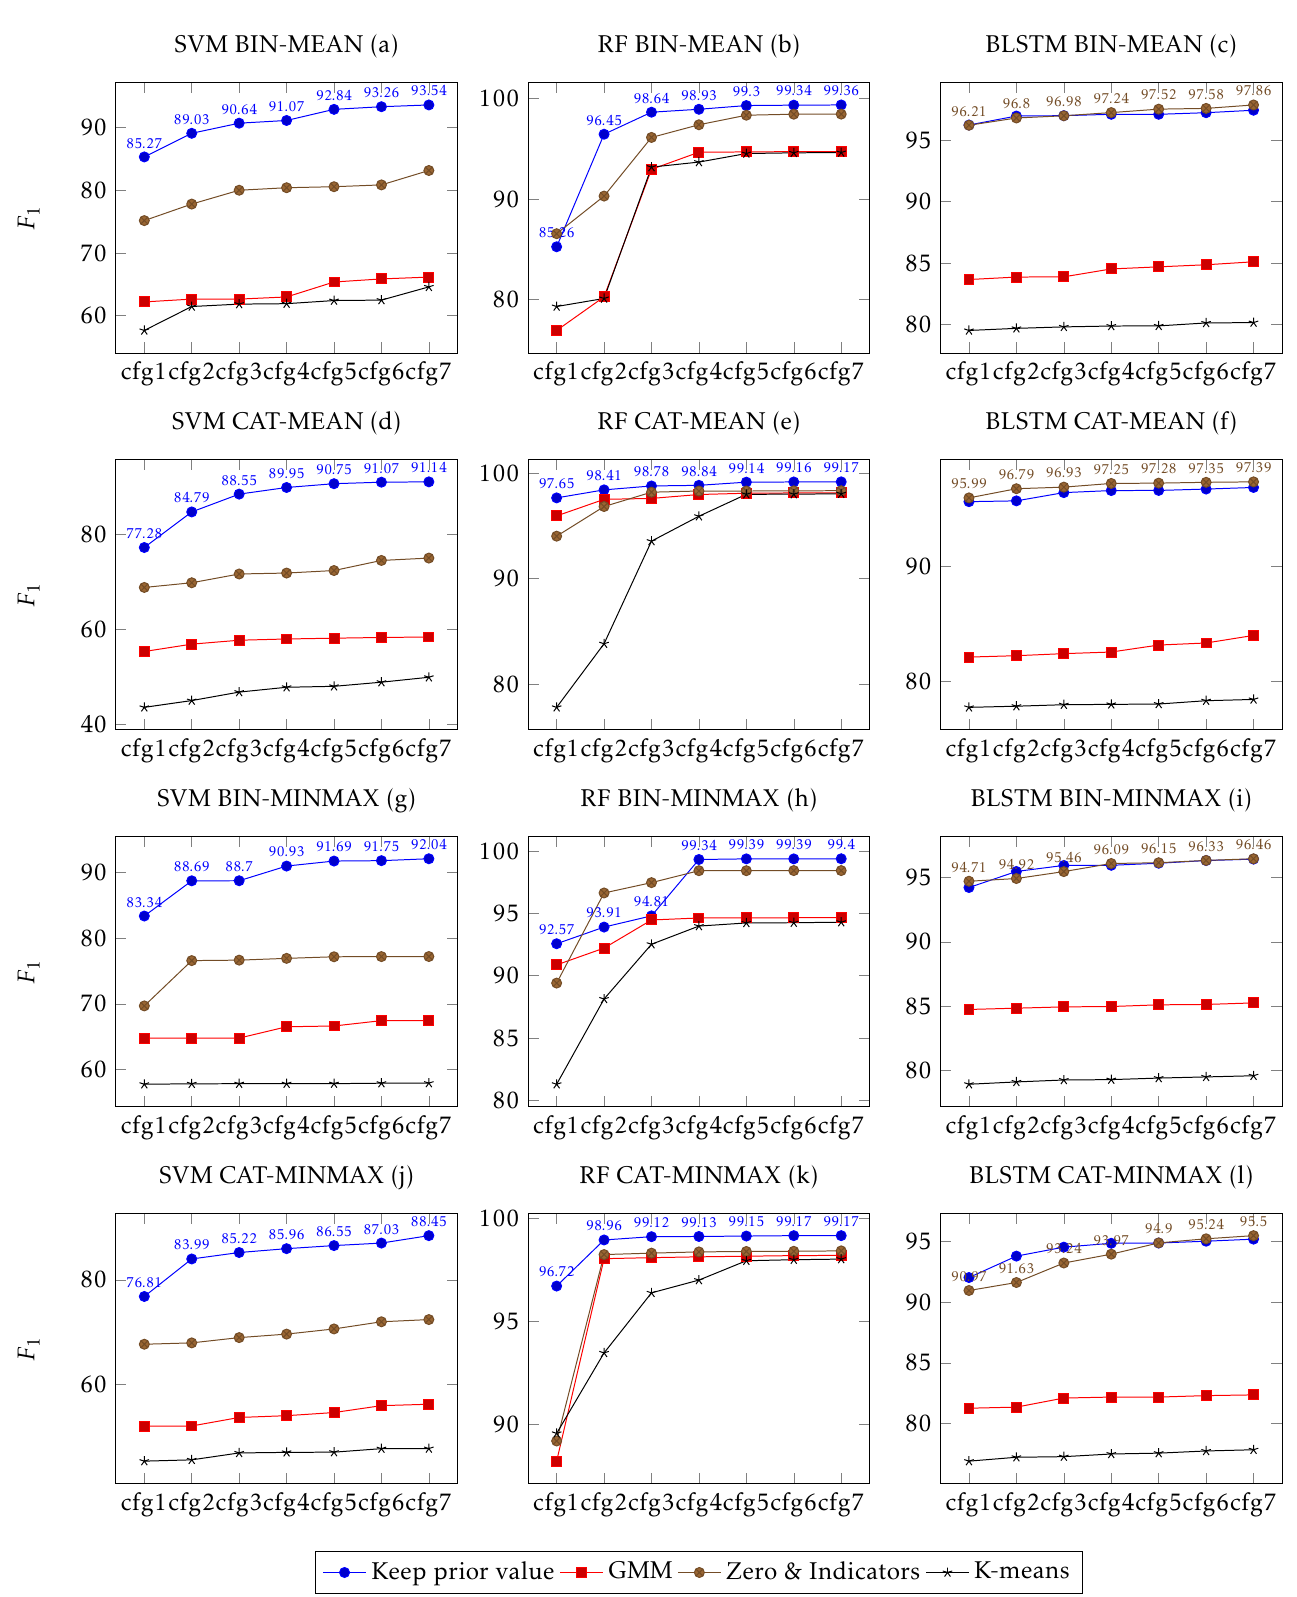
Figure 8. Results for the hyperparameter search for SVM, RF, and BLSTM. The first row shows the results for the binary classification (BIN) using the mean-standard deviation normalization strategy (MEAN), the second row for the categorical classification (CAT) using MEAN. The third row shows the results for BIN using the min-max normalization strategy (MIN-MAX) and finally the fourth row for CAT using MIN-MAX. On the x axis are the different configurations for the hyperparameter depicted and on the y axis is the F